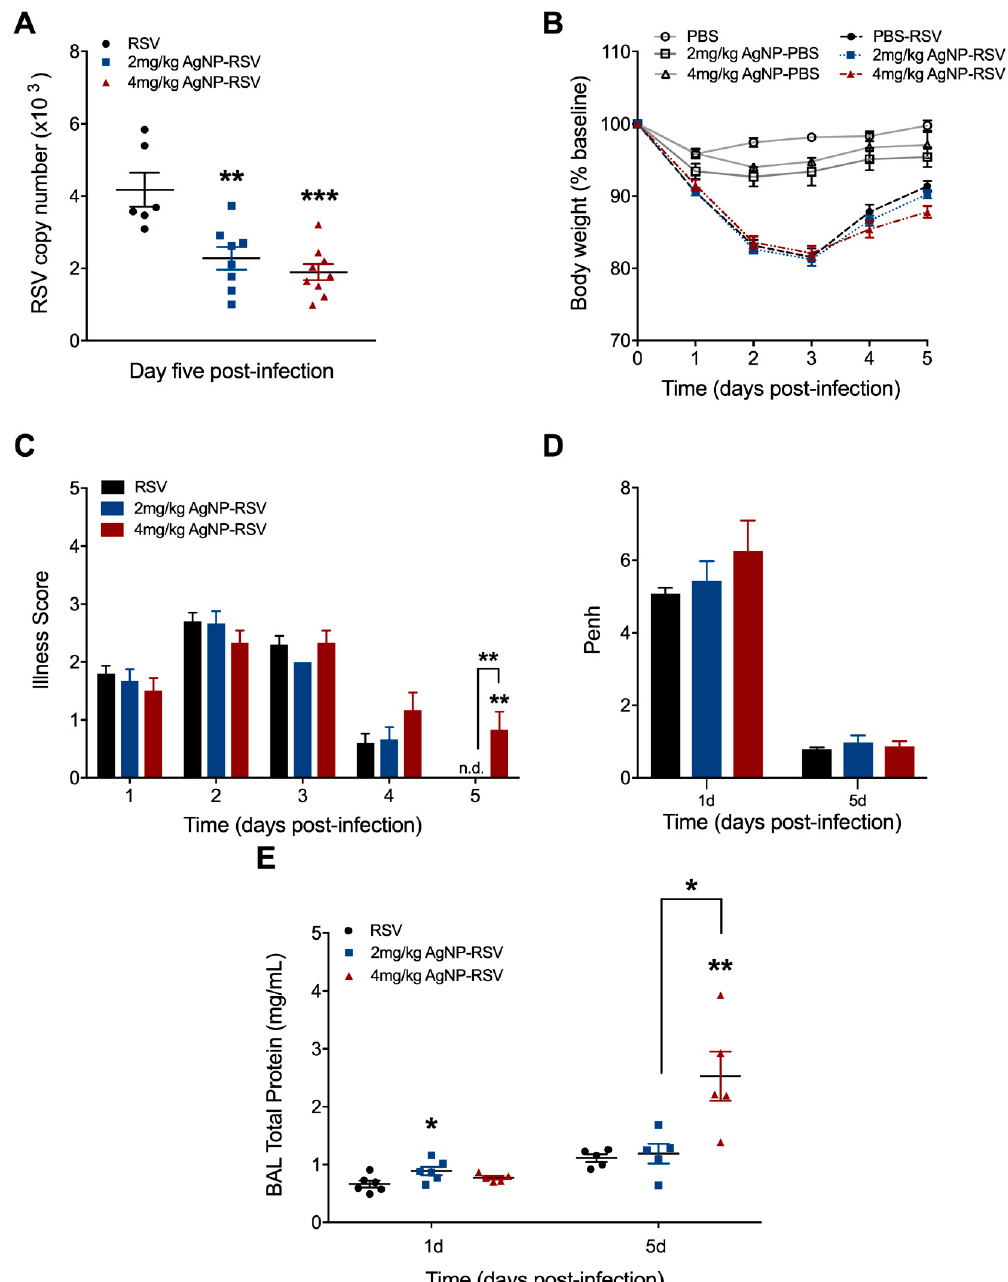
Figure 2. AgNPs decreased RSV replication in the lung tissue of experimentally infected mice. Under light anesthesia, mice were intranasally inoculated with either phosphate-bu ff ered saline (PBS), AgNP-PBS (2 mg / kg or 4 mg / kg), RSV (5 × 10 6 PFU) or AgNP-RSV. Lung tissue collected at day five p.i. was measured for ( A ) viral titer by qRT-PCR. Over the five-day infection period, mice were monitored daily for changes in ( B ) bodyweight and ( C ) illness score. ( D ) Airway obstruction, represented by baseline Penh, was assessed by unrestrained plethysmography (Buxco Electronics, Inc., Sharon, CT, USA). ( E ) Total protein concentrations of the bronchoalveolar lavage fluid (BALF) at days one and five p.i. were determined using the Bradford method (BioRad Laboratories, Hercules, CA, USA). Data are expressed as mean ± SEM (n ≥ 5 mice) and is representative of three independent experiments. Significant results as compared to the respective control are marked with asterisks, and additional comparisons between groups are indicated with brackets (* for p ≤ 0.05, ** for p ≤ 0.01, *** for p ≤ 0.001, **** for p ≤ 0.0001). Not detected (n.d).